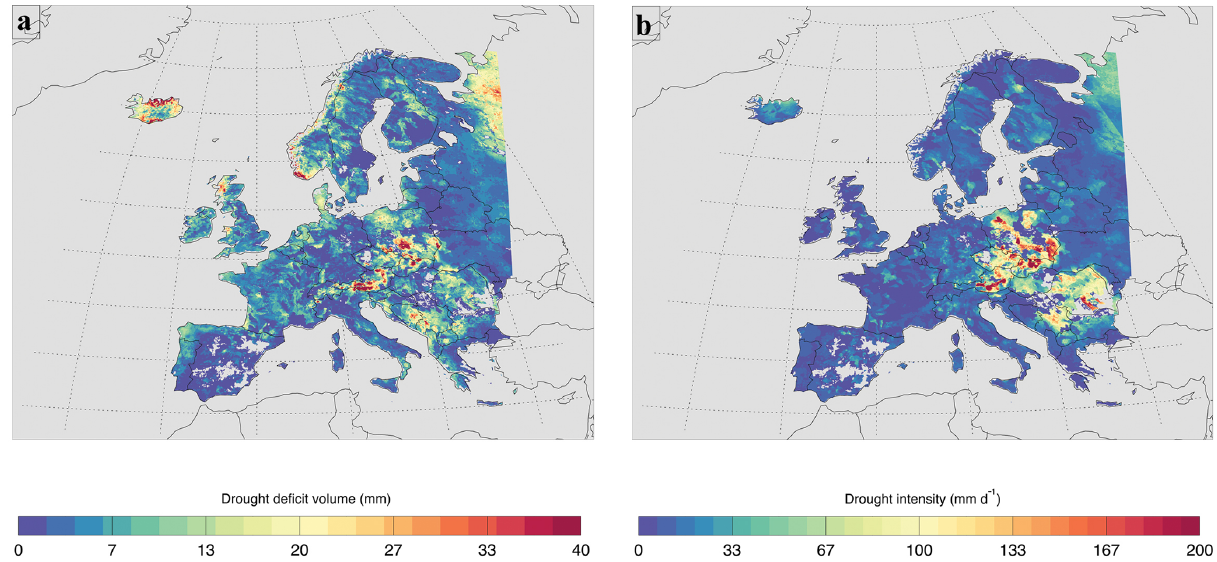
Figure 4. Spatial distribution of the average annual drought deficit volume (mm per year in drought years) derived from drought in runoff (a) and the average annual drought intensity (mm per day in drought years) derived from drought in groundwater (b) , over the period 1990–2017. Non-drought years are